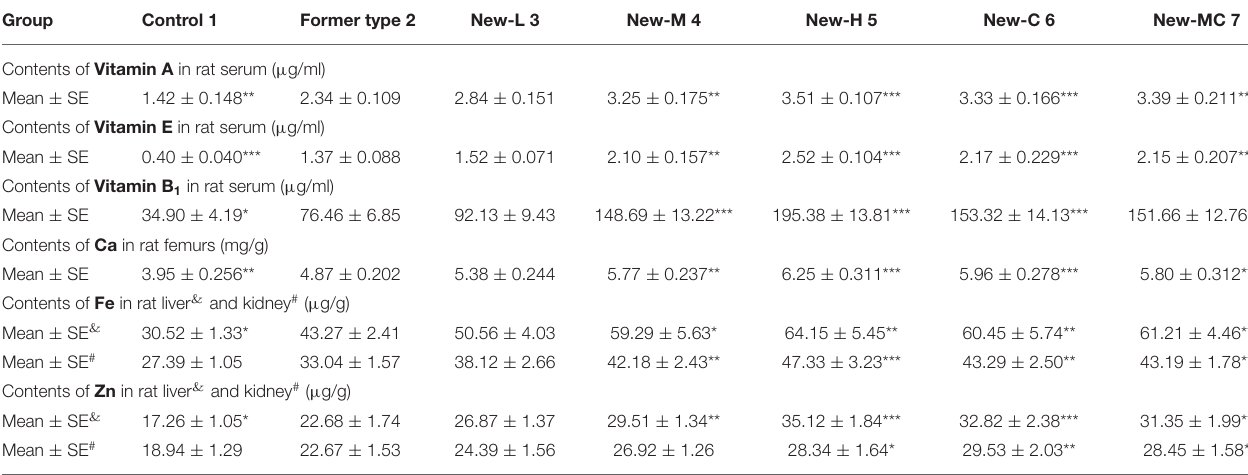
TABLE 2 | The contents of tested vitamins A, E, B 1 , and minerals Ca, Fe, Zn in vivo . Group Control